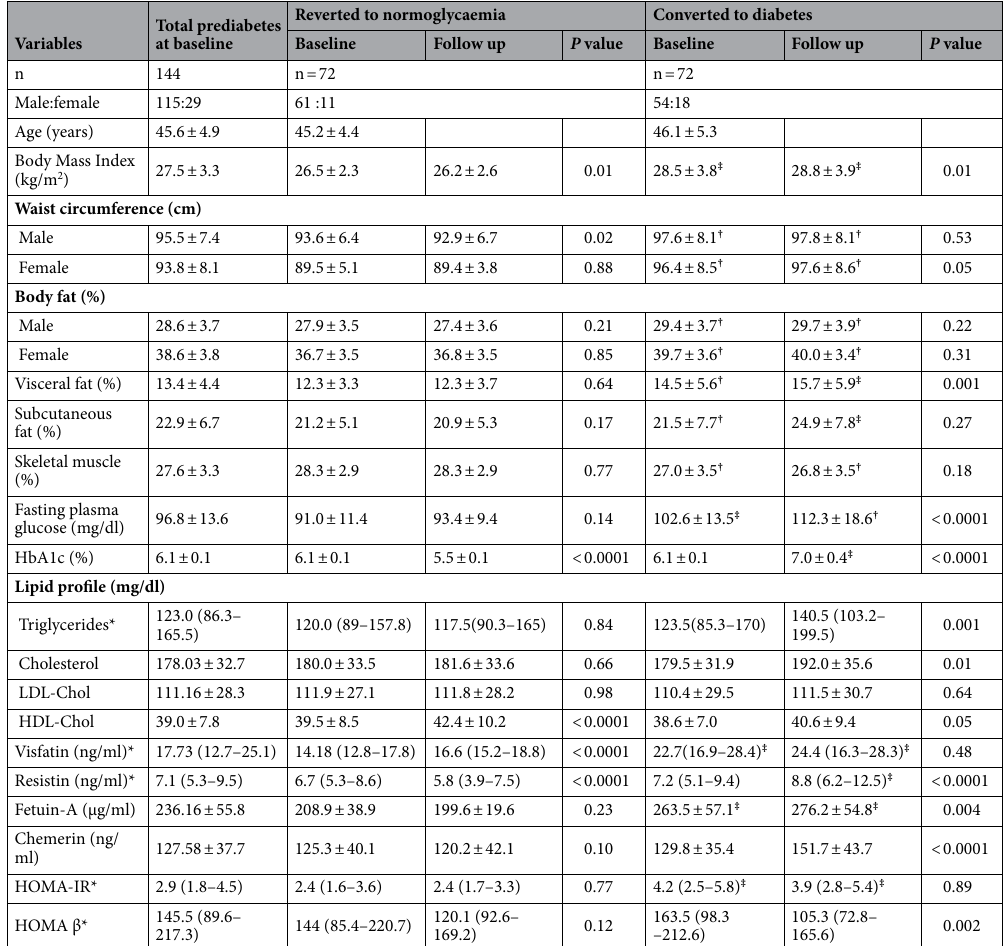
Table 1. General characteristics of the study groups—baseline and follow up. *Median (IQR) for non- normally distributed variables/Mean ± SD for normally distributed variables. Intra-group comparison (Baseline vs. Follow up) - Paired t test (parametric), Wilcoxon signed-rank Test (non-parametric). Inter-group comparison (NGT vs. DM) - Un-Paired t test (parametric): † p value < 0.05, ‡ p value < 0.0001, Mann–Whitney (non-parametric): † p value < 0.05, ‡ p value < 0.0001. HbA1c glycosylated haemoglobin, LDL-Chol low density lipid cholesterol, HDL-Chol high density lipid cholesterol, HOMA-IR homeostatic model assessment of insulin resistance, HOMA β homeostatic model assessment of β-cell